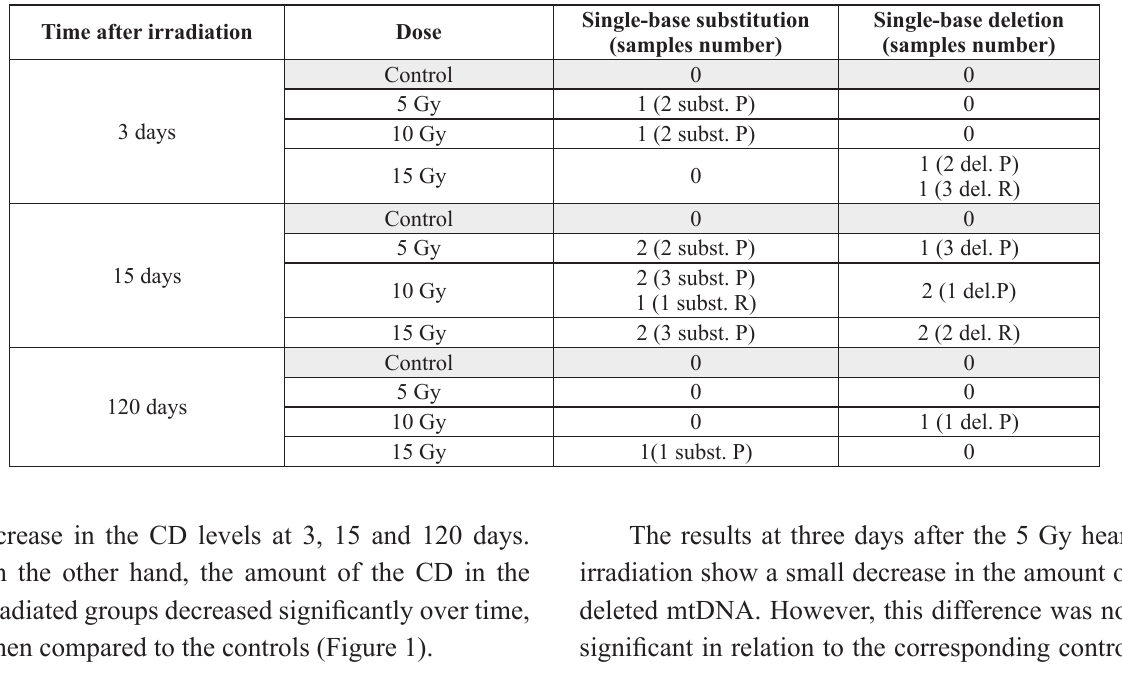
Single-base substitutions and single-base deletions were observed in the 16 bp sequence that